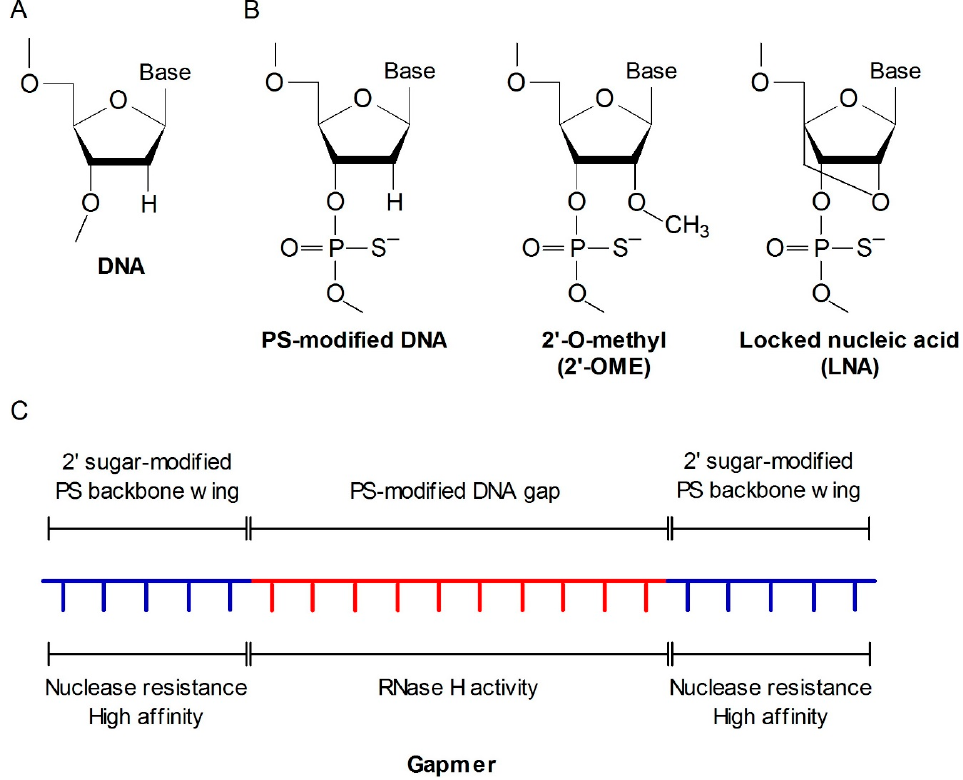
Figure 2. Chemical modifications of ASO. ( A ) Basic structure of a DNA oligonucleotide; ( B ) Chemical modifications of ASOs; ( C ) Structure of a gapmer. The 3rd generation of ASOs are mostly designed with a gapmer structure, typically with 20 nucleotides of phosphorothioate (PS)-modified backbone. The central sequence consists of approximately 10 simple PS-modified DNA residues, referred to as the gap, that can bind RNase H and induce the cleavage of target mRNA. Sugar-modified residues are overhanged on both ends of the gap as protective wings to resist nuclease activity and increase mRNA binding affinity.